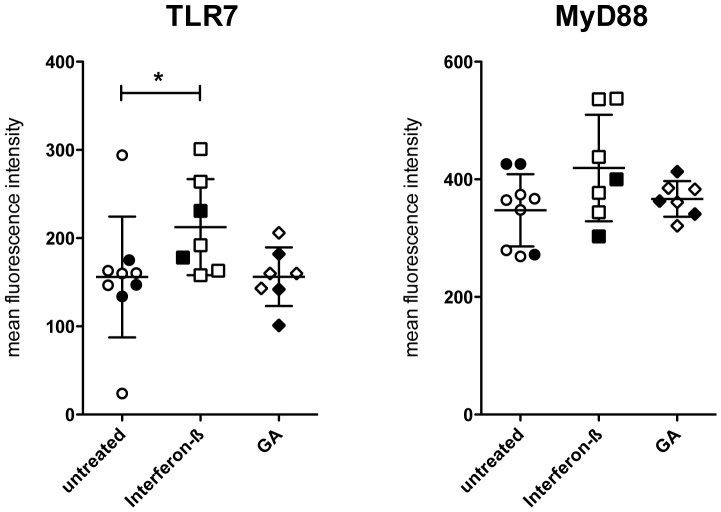
Increased TLR7 and MyD88 protein expression in plasmacytoid dendritic cells of interferon-β-treated patients with MS.Expression of TLR7 and MyD88 in pDCs of 9 untreated, 7 interferon-β-, and 7 glatiramer acetate-treated patients with CIS/RRMS was analyzed by flow cytometry. Results are expressed as MFITLR7 or MyD88 – MFIisotype with each dot representing one individual. Empty symbols represent female and filled symbols male individuals. Statistical significance of differences was assessed by Mann Whitney U test. GA, glatiramer acetate; *p<0.05.